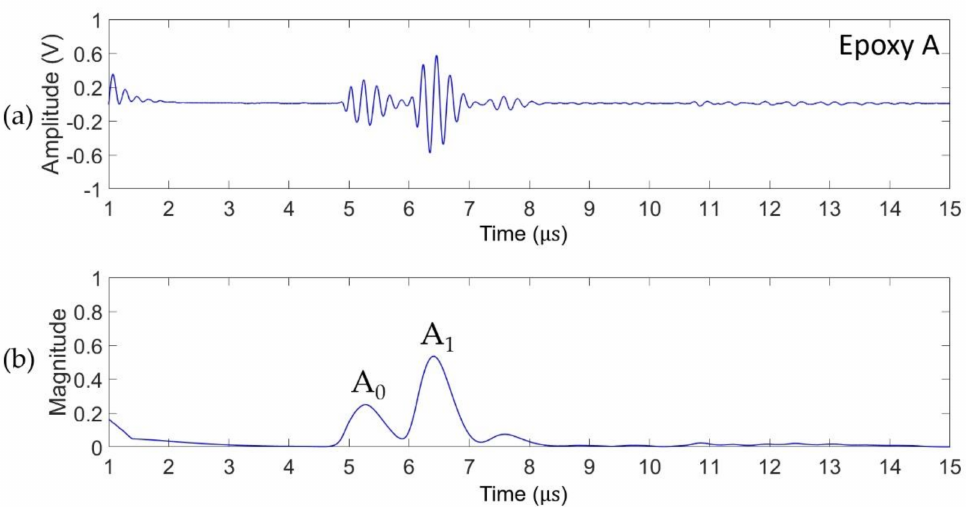
Figure 4. Epoxy A coating layer with a thickness less than 1.5 mm: ( a ) time-domain waveform and ( b ) the projection of the STFT of the waveform into the